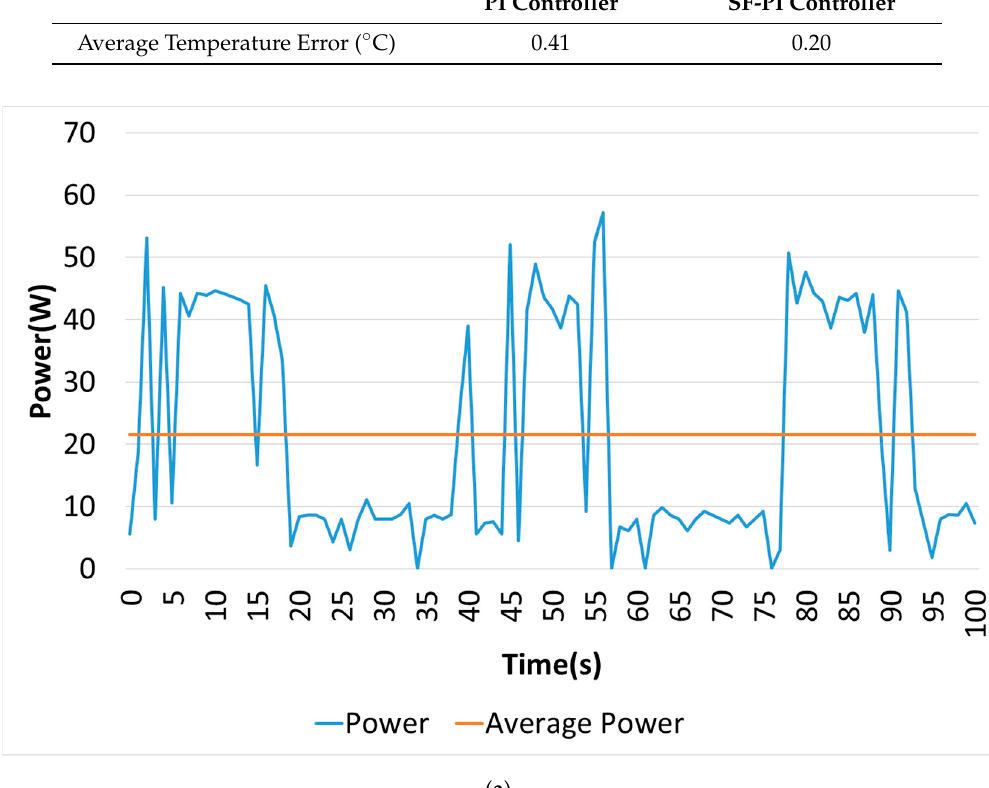
( b ) Figure 20. Consumption power comparison for changing temperature and humidity. (a) PI Control- ler. (b) SF-PI Controller. Table 11. Average consumption power comparison for changing temperature and humidity. PI Controller